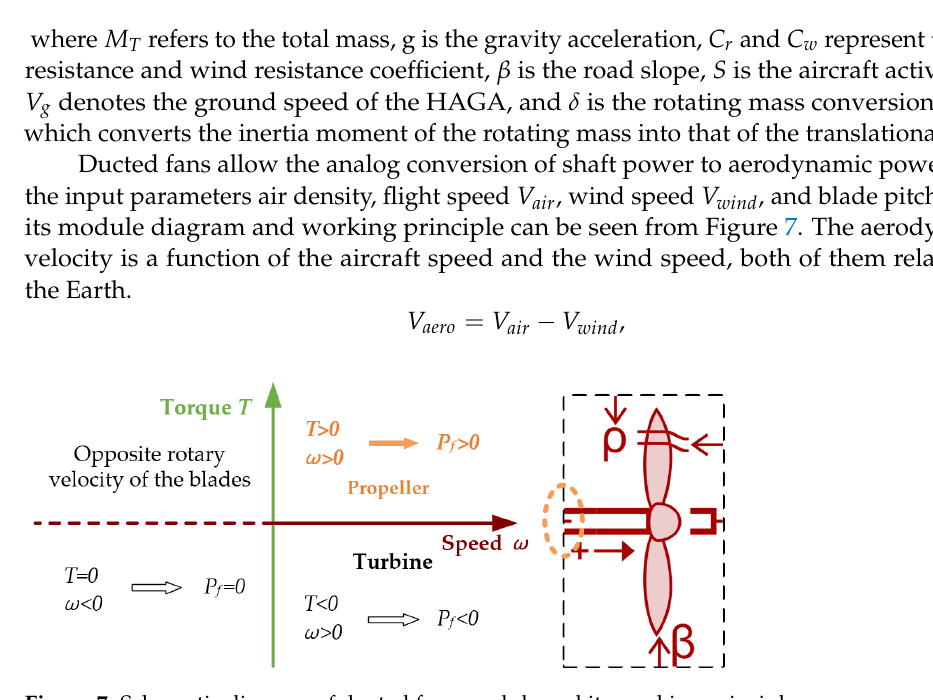
Figure 7. Schematic diagram of ducted fans module and its working